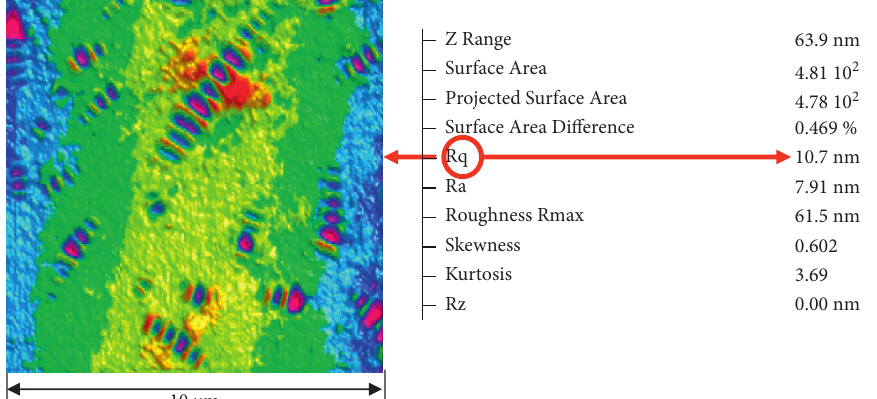
Figure 15: Test method of the roughness.